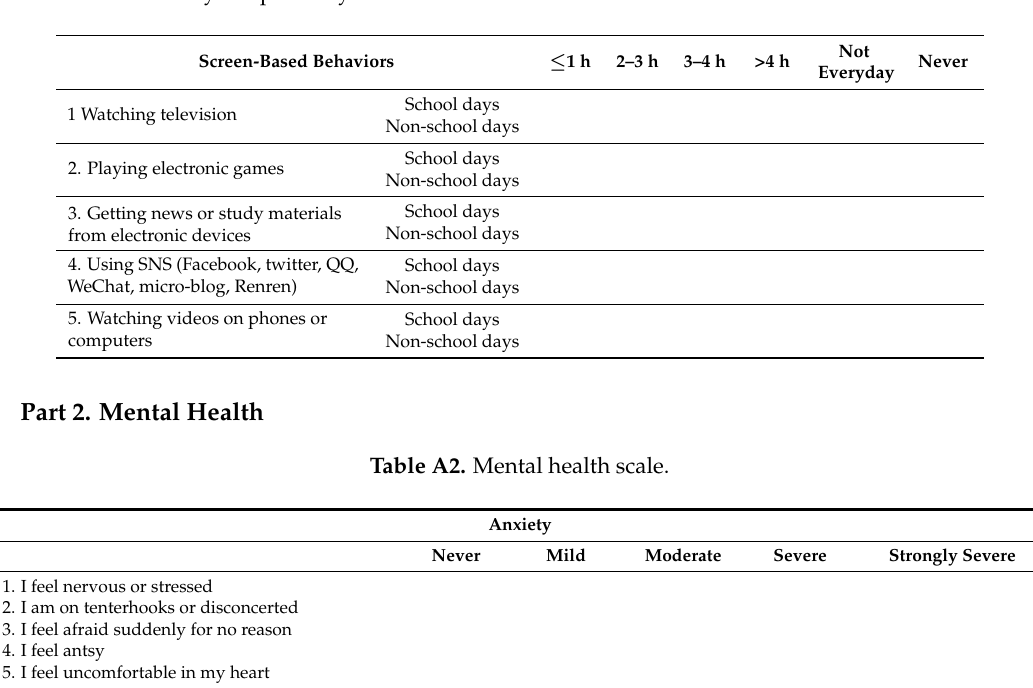
Table A1. How many hours do you usually spend every day on the following activities at school days and non-school days respectively?